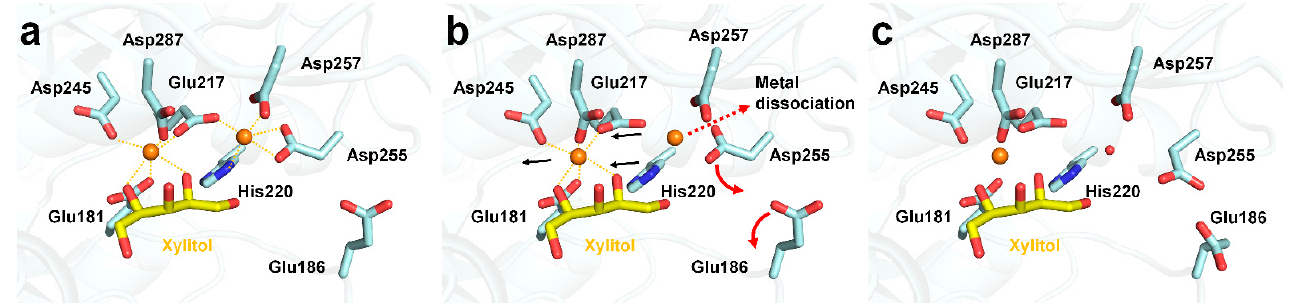
Figure 6. Proposed mechanism of xylitol ‐ induced release of metal at the M2 site of GI. ( a ) Xylitol ‐ bound state of GI. ( b ) Rearrangement of xylitol ‐ binding residues. ( c ) Release of metal ion from M2 site of GI.